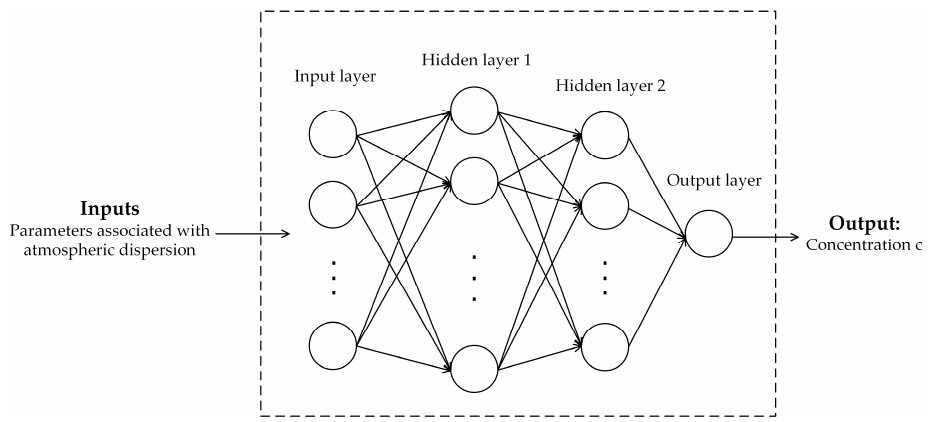
Figure 1. The structure of the back propagation (BP) fitting network for prediction.